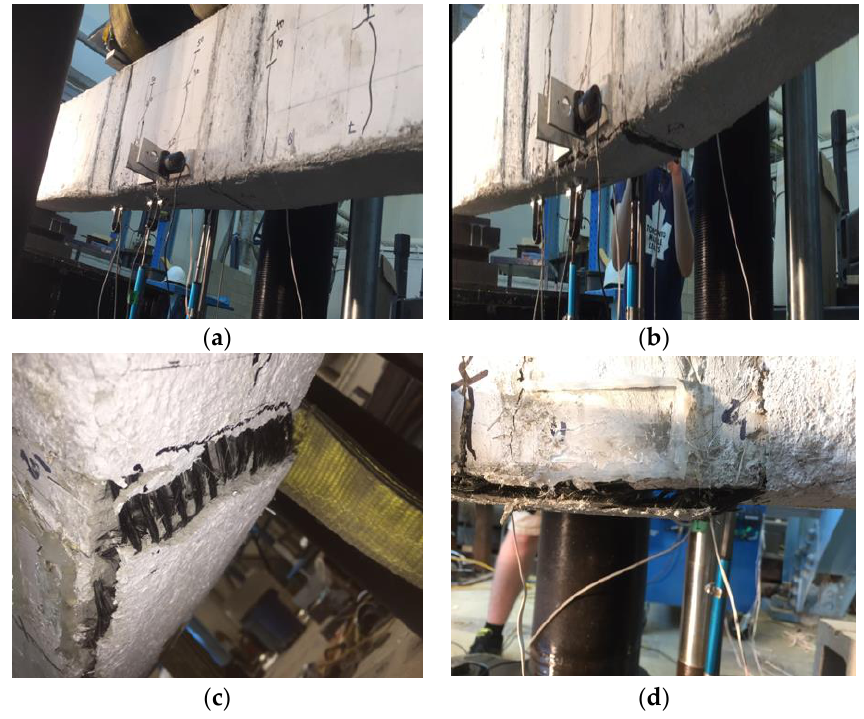
Figure 13. Carbon FRCM-strengthened beam failure mode. ( a ) and ( b ): Premature detachement of Carbon FRCM; ( c ): Slippage of fibers; ( d ): Detachment of FRCM.